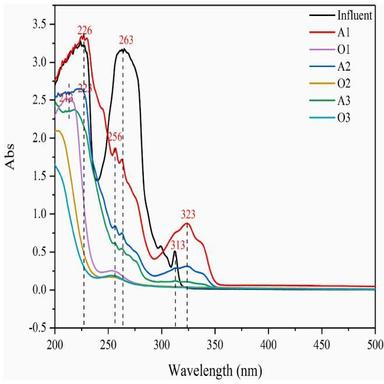
UV–vis spectra in the influent and effluent from different stages.